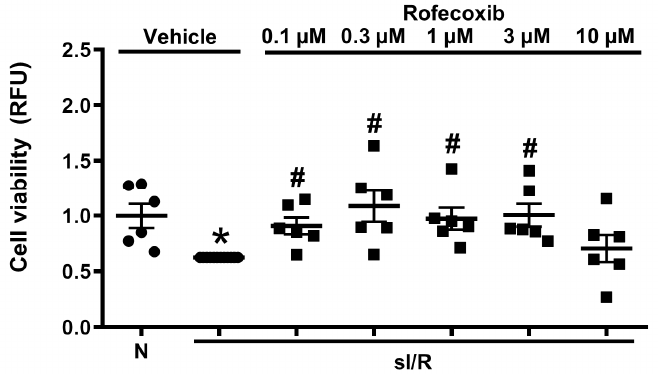
Figure 9. Rofecoxib increased cell viability in isolated rat cardiac myocytes exposed to simulated ischemia / reperfusion (sI / R). Normoxia (N) + vehicle group was set to 1 relative fluorescence units (RFU) arbitrary unit and all of the data were normalized to the averaged sI / R group (* p < 0.05 vs. Normoxia + vehicle, # p < 0.05 vs. sI / R + vehicle, n = 6). RFU-arbitrary unit: Relative fluorescence unit.